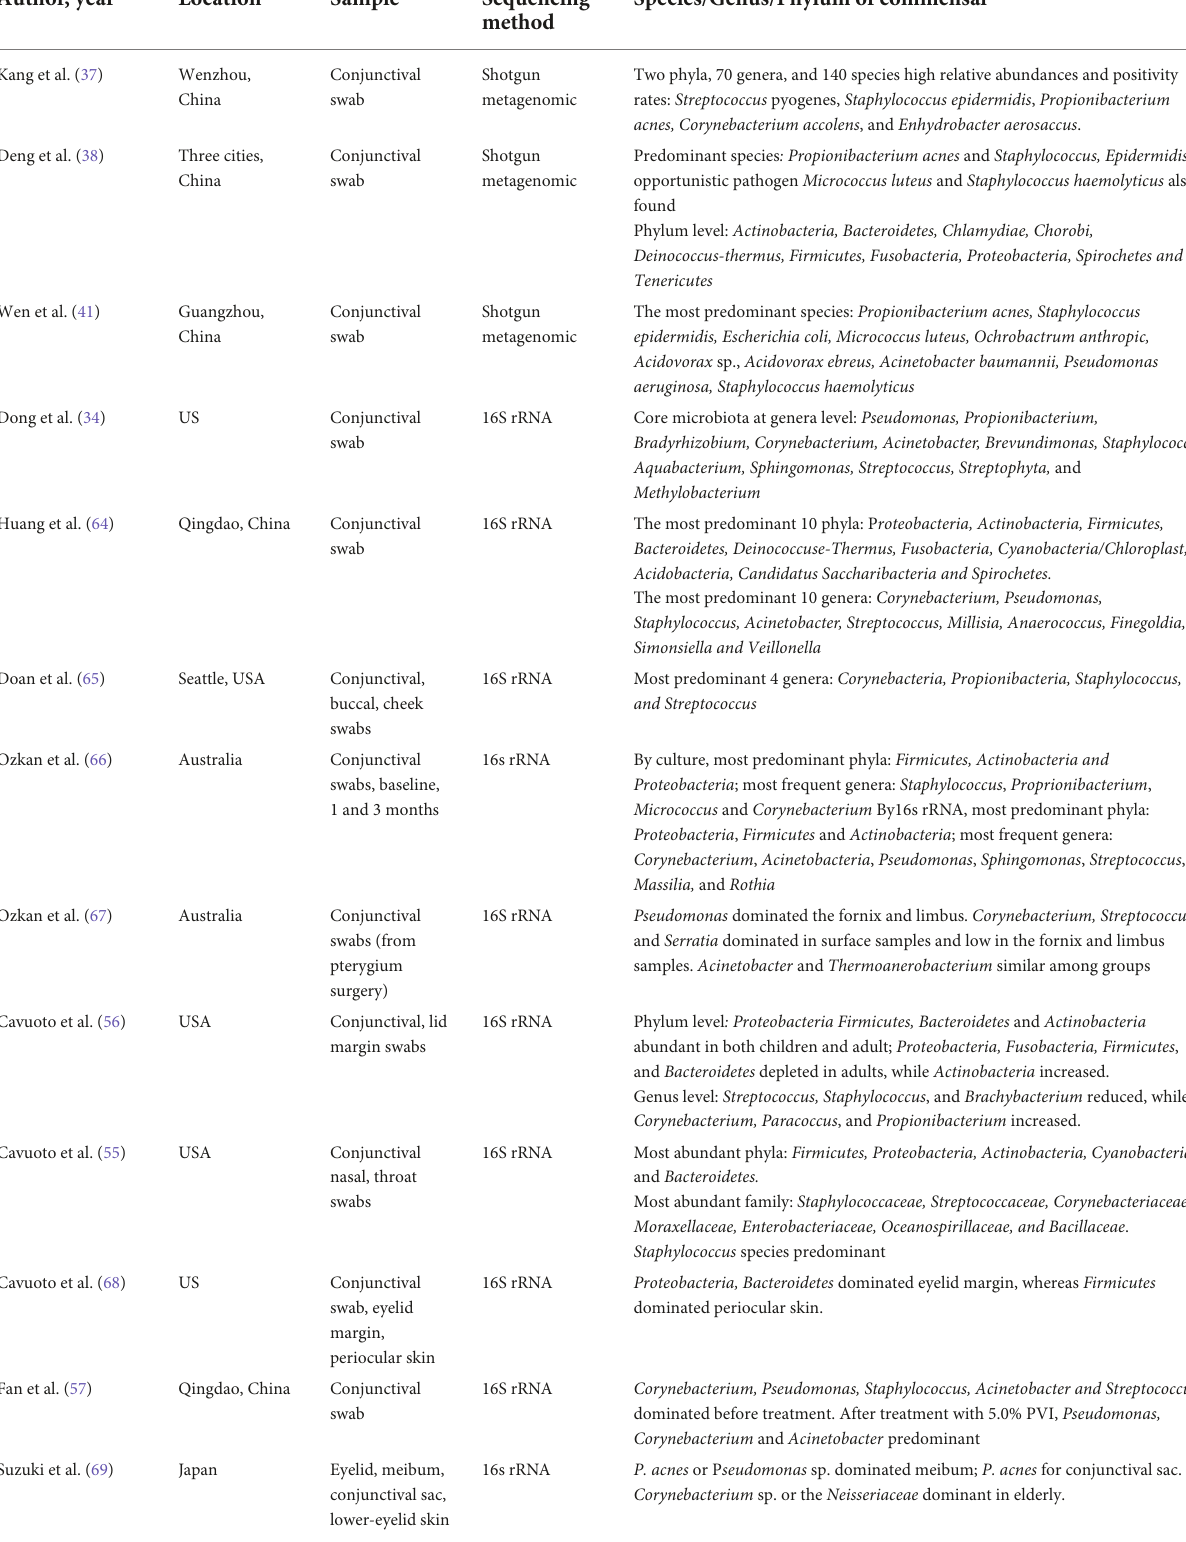
TABLE 3 Studies of healthy ocular surface